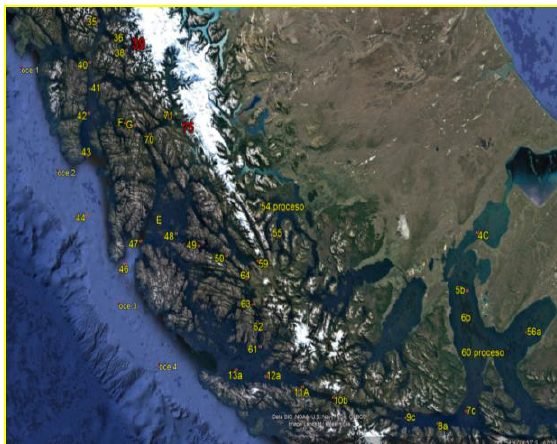
Fig. 1. Study area with oceanographic stations of CIMAR 25 cruise (September/October 2019).